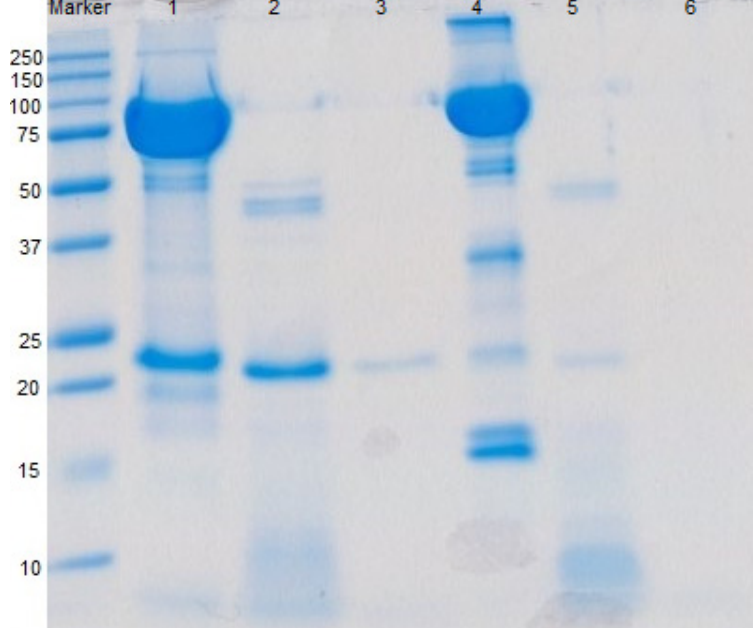
Figure 3. Deer and cow Lf degradation during in vitro digestion. Lane 1: deer Lf; lane 2: 60 min gastric